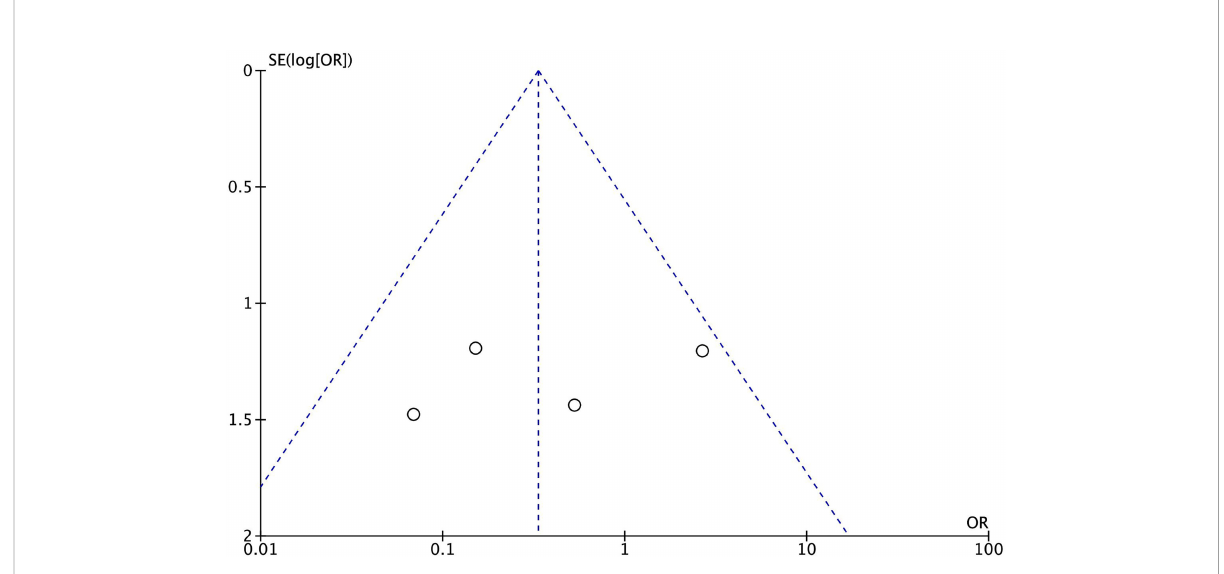
FIGURE 2 Funnel plot of the effect of reparixin on mortality according to the six included randomized studies.